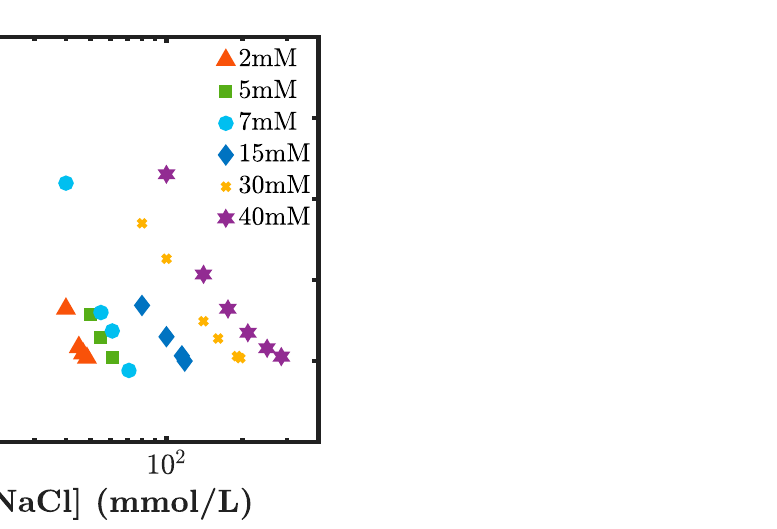
Figure 6. Swelling ratio W r of the dual-crosslink hydrogel for different initial concentrations in NiCl 2 , versus the NaCl concentration in the solution.